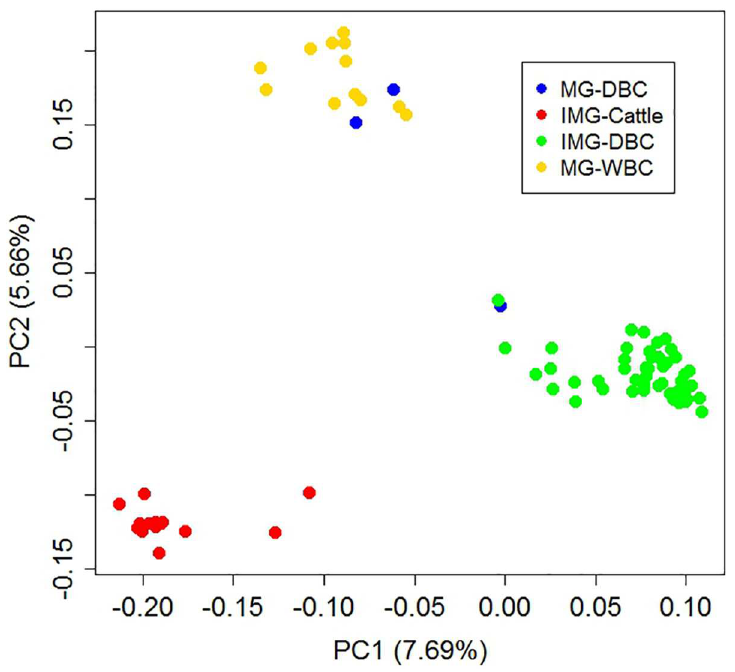
Fig 3. Principal component analysis (PCA) with weighted UniFrac distance analysis of the microbiomes from the four animal populations.